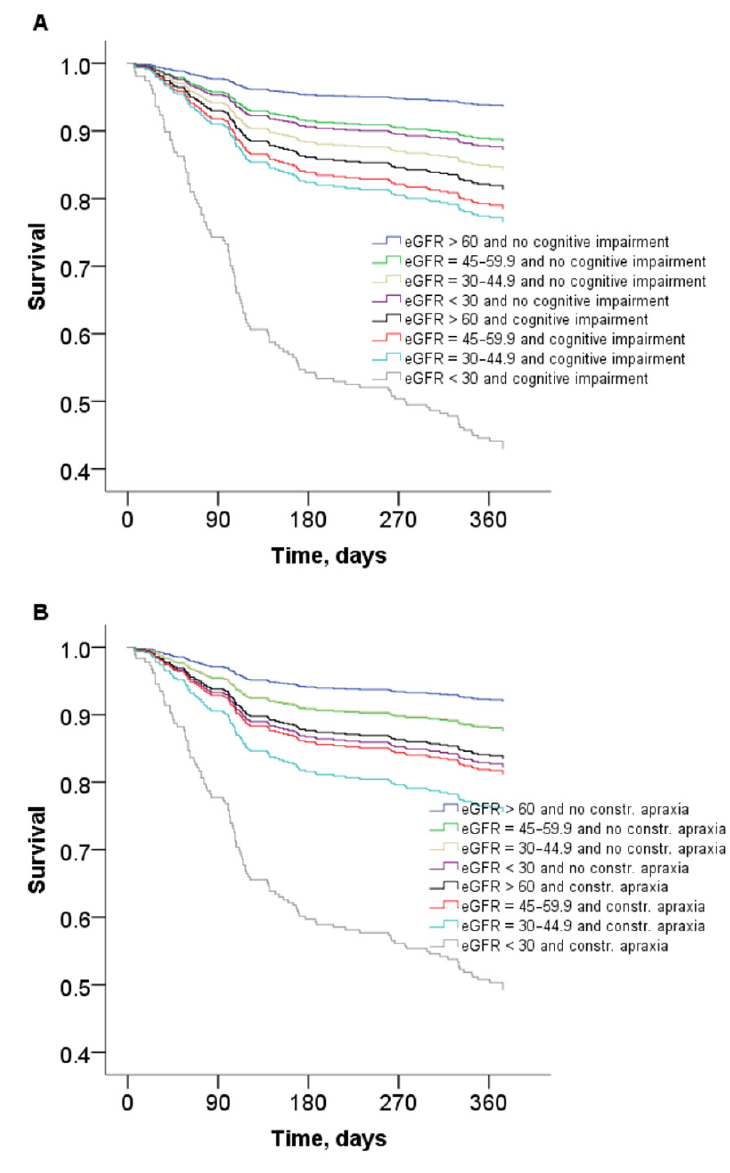
Figure 1. Kaplan–Meier curves showing survival associated with estimated glomerular filtration rate (eGFR) among patients ( A ) with or without overall cognitive impairment (log-rank = 69.9, p < 0.001) or ( B ) defective constructional praxis (log-rank = 52.7, p < 0.001).